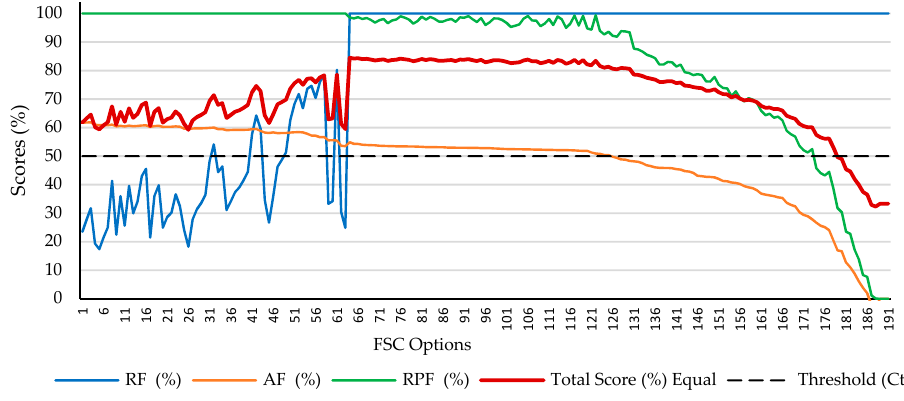
Figure 13. Graphical presentation of all FSCs that satisfy the load demand at 22 kWh/day.